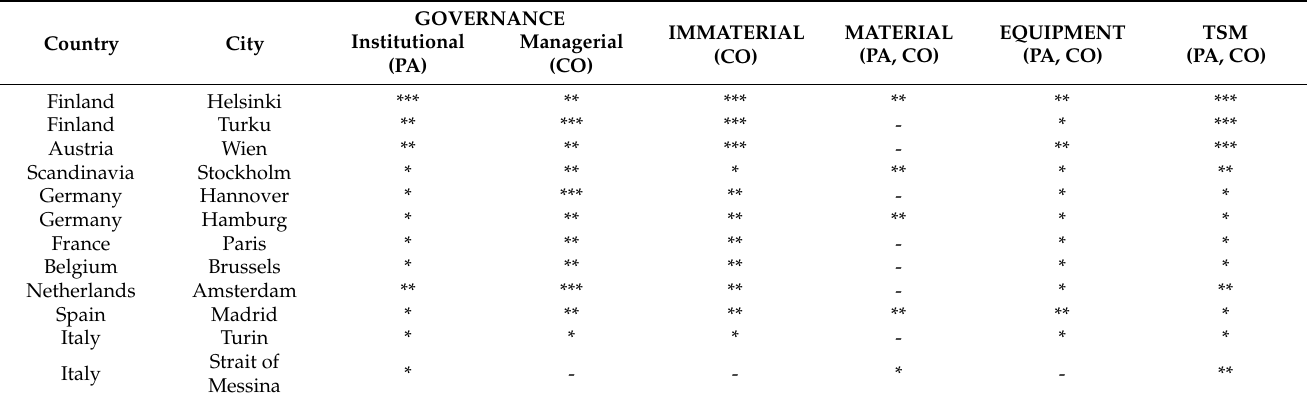
Table 3. Real advanced case studies: review of the supply